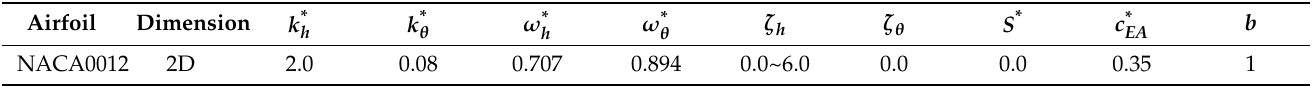
Table 3. Baseline case